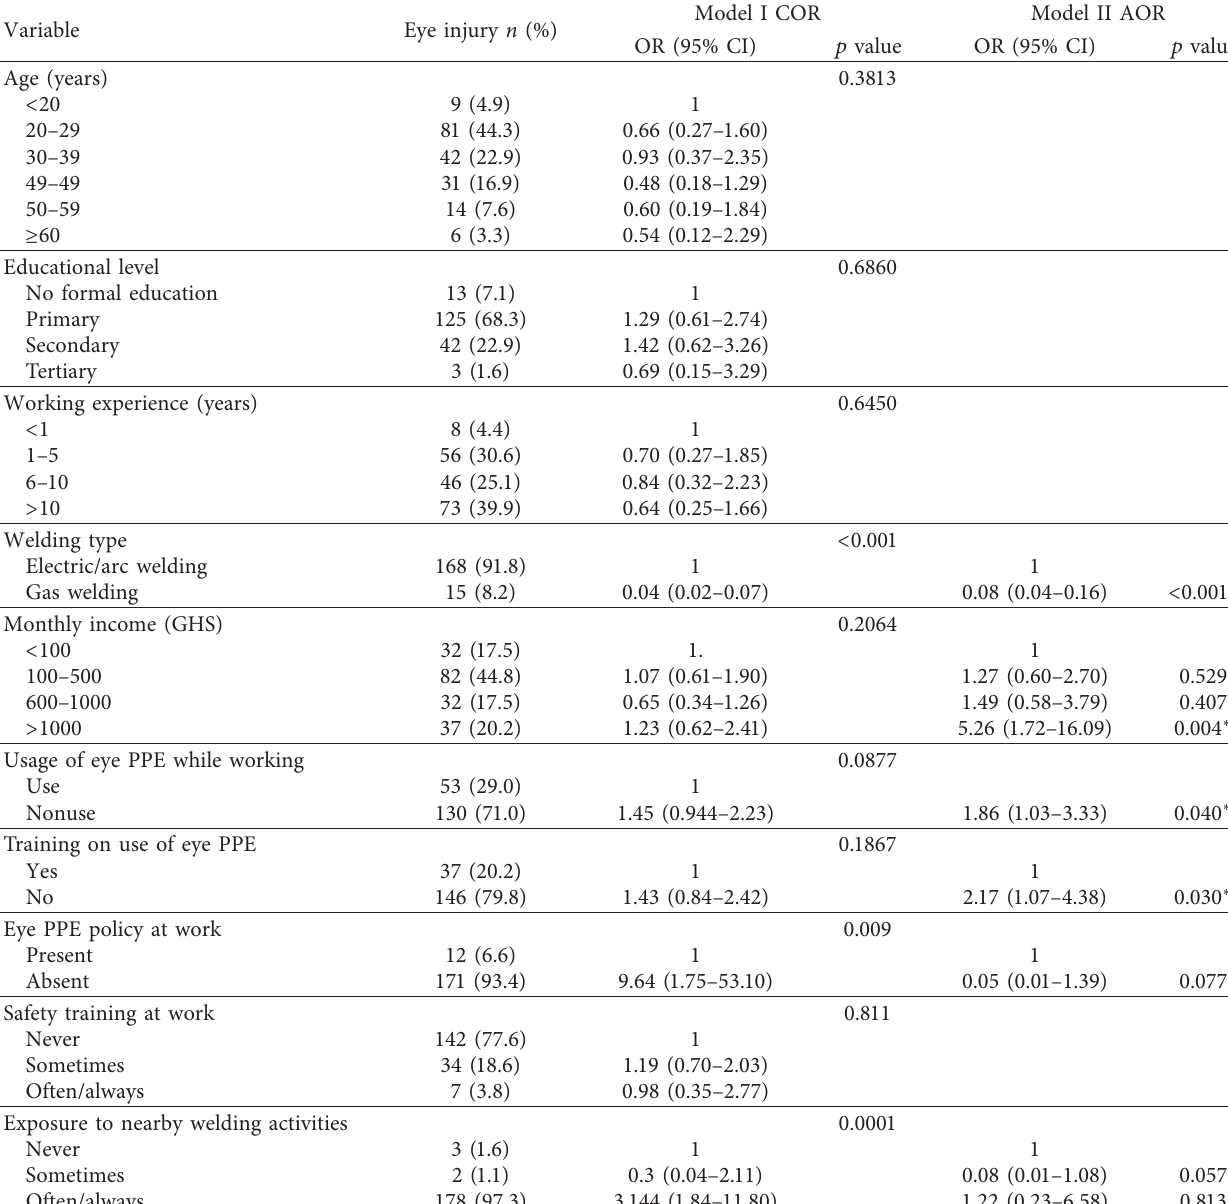
Table 4: Factors associated with eye injuries among